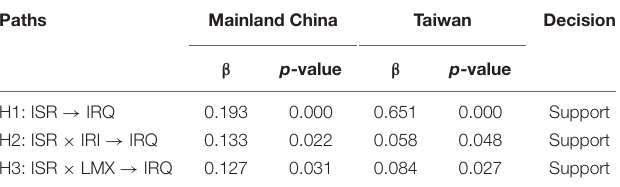
TABLE 3 | Results of the hypotheses